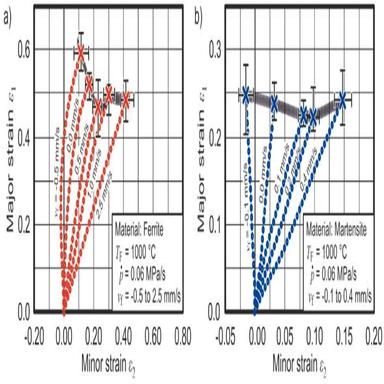
Forming limit diagrams from the hot-tube-bulge test as well as the corresponding strain paths at Tγ = 1000 ◦C with newly defined limits for a) ferritic- and b) martensitic stainless steel tube material.